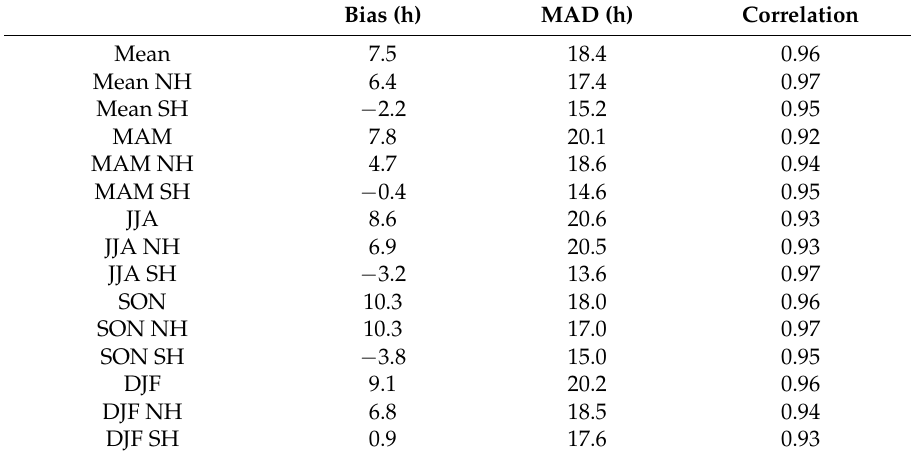
Table 2. Bias, MAD and correlation for the comparison of daily SDU and CLIMAT for the time period 1983–2015. The mean includes 117.933 compared monthly values. The Northern Hemisphere (NH) is defined by latitude >23 ◦ , the Southern Hemisphere (SH) by latitude < − 23 ◦ . Seasons are divided into March to May (MAM), June to August (JJA), September to November (SON) and December to